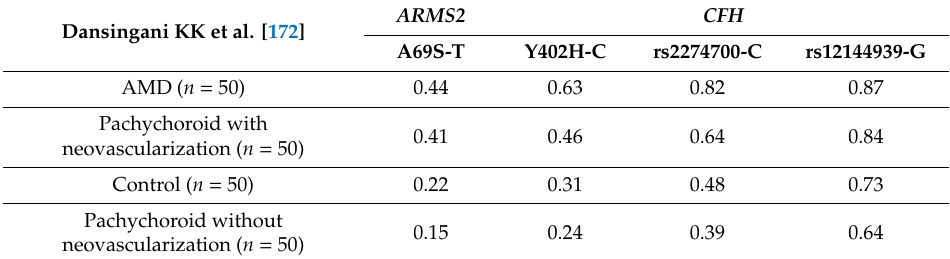
Table 5. Risk allele frequencies for age-related macular degeneration in